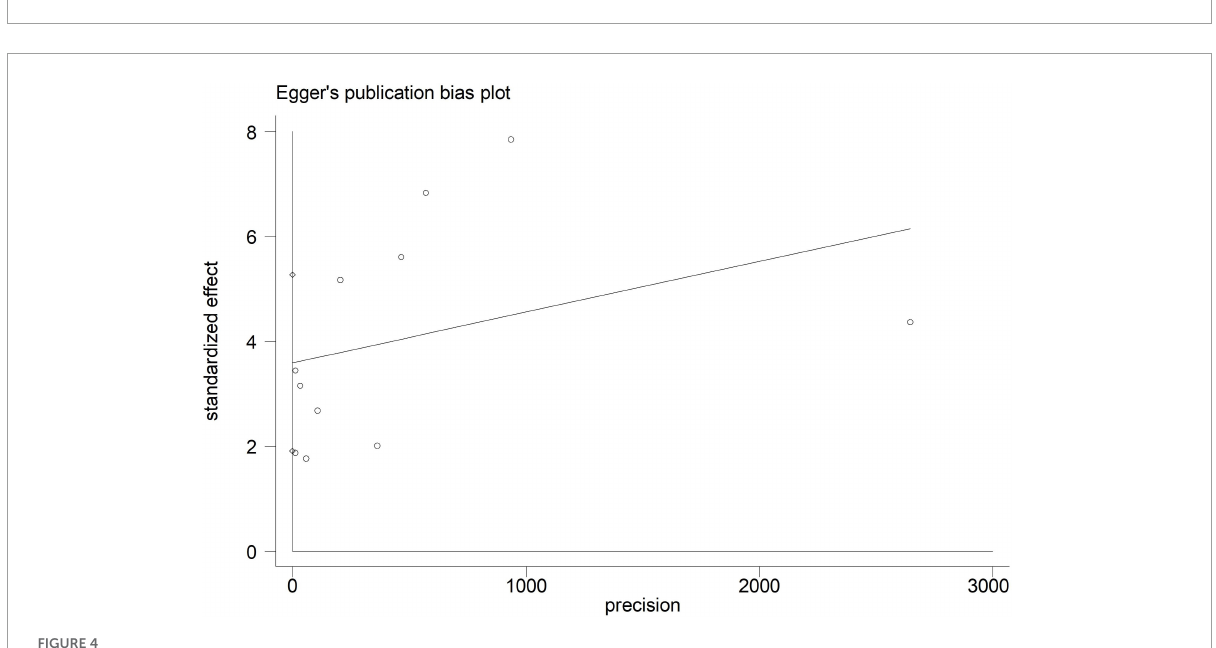
FIGURE4 Egger’s funnel plot analysis of cardiopulmonary bypass (CPB) in adults.